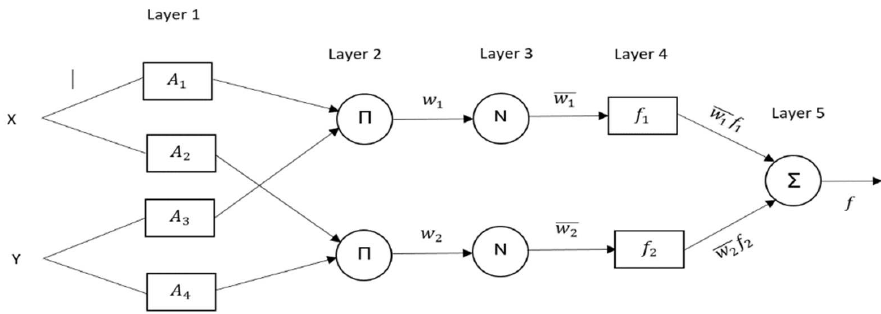
Figure 2. ANFIS model based on two input variables and one output.